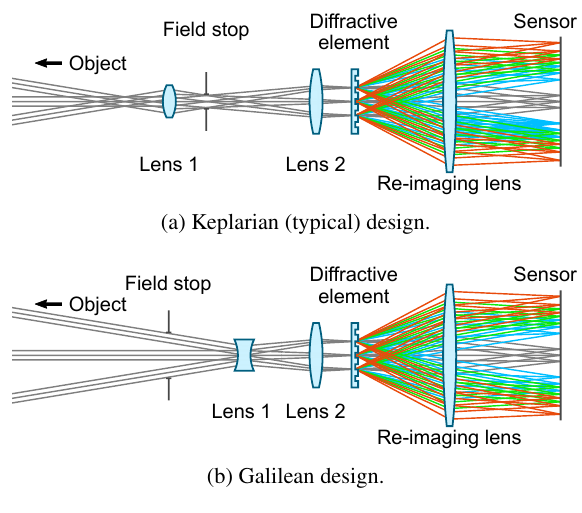
Figure 1: Di ff erent CTIS designs using a Keplarian and a Galilean beam